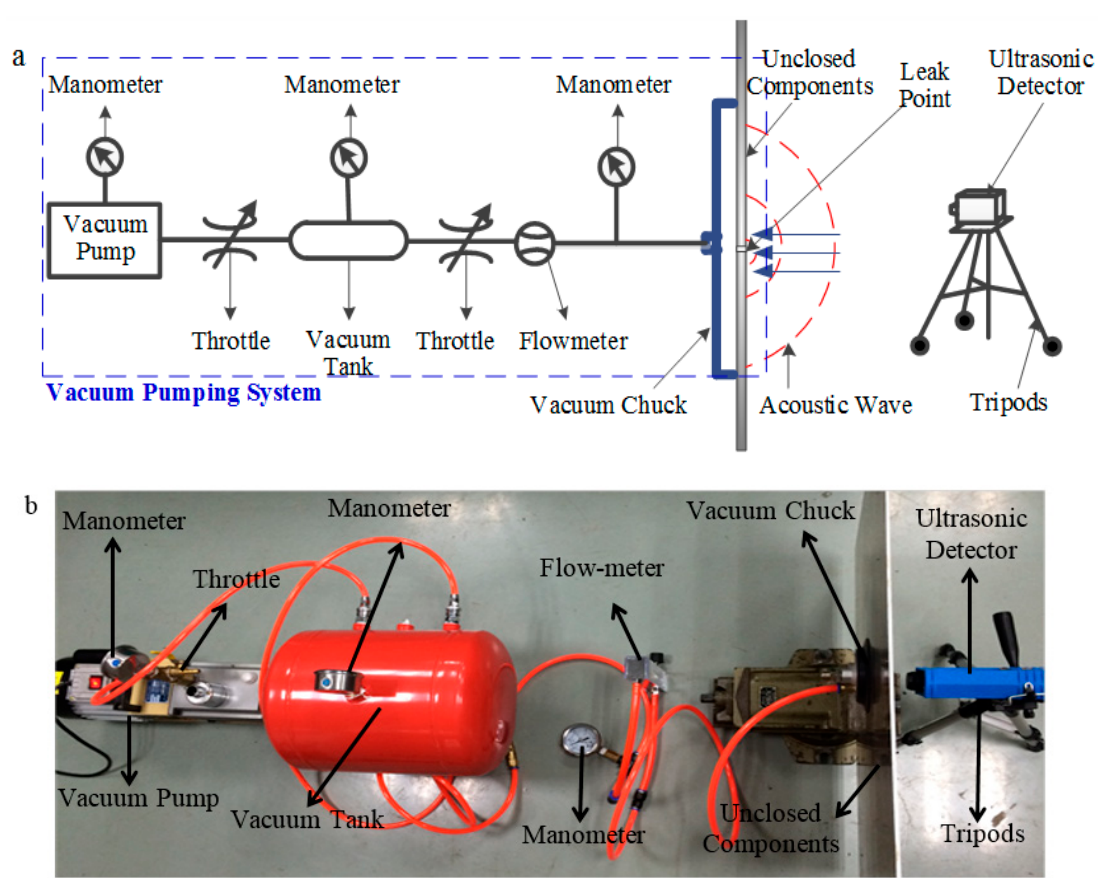
Figure 2. The ultrasonic-based detection system for unclosed components: ( a ) Schematic diagram; ( b ) Experimental setup.